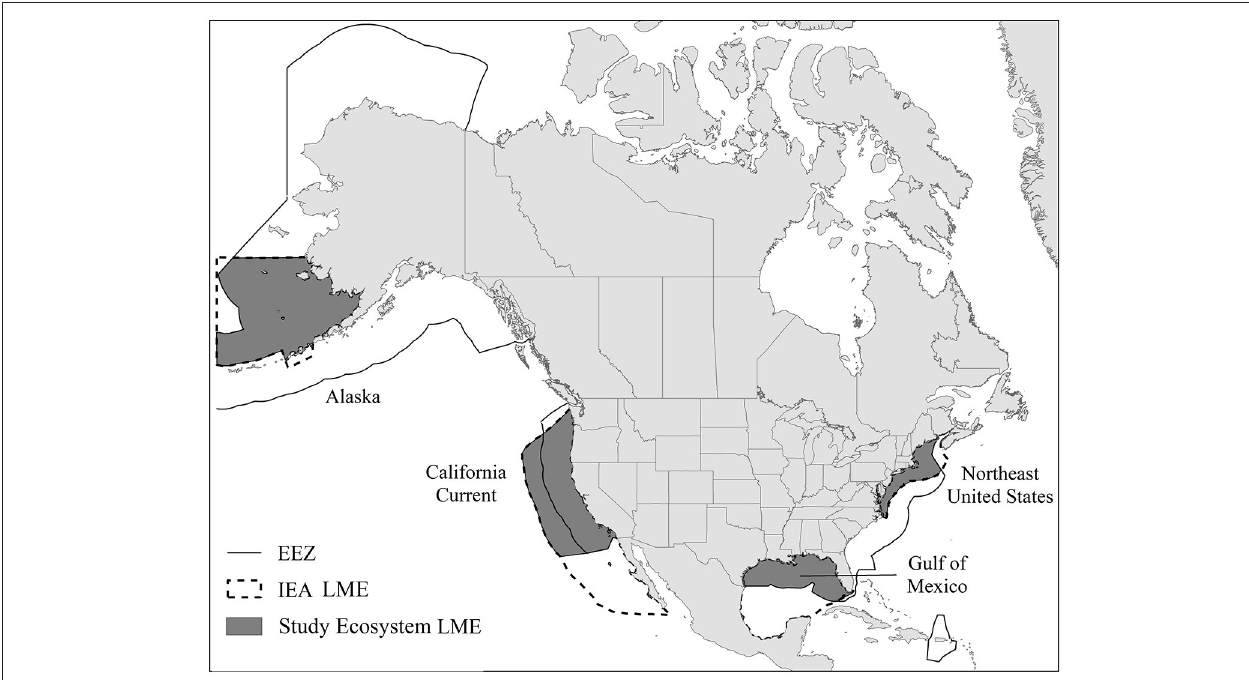
FIGURE 1 | Study large marine ecosystem (LME; gray). Solid lines represent the US exclusive economic zone (EEZ) and dotted lines represent the integrated ecosystem assessment large marine ecosystem (IEA LME).